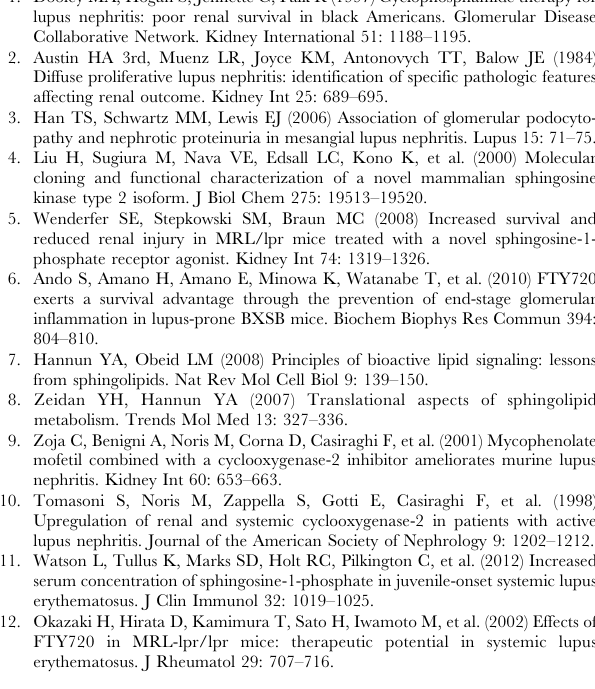
Table S1 Pathology Scores. Following 10 weeks of treatment with either vehicle or ABC294640 kidney pathology was assessed by a blinded pathologist Values are mean 6 SD. *Significantly different from MpJ + vehicle, p , 0.05; ***Significantly different from MpJ + vehicle, p , 0.01 by One-way ANOVA; n $ 10. Table S2 Spleen Weight, splenic T and B cell counts. Following 10 weeks on either vehicle or ABC294640 spleens were